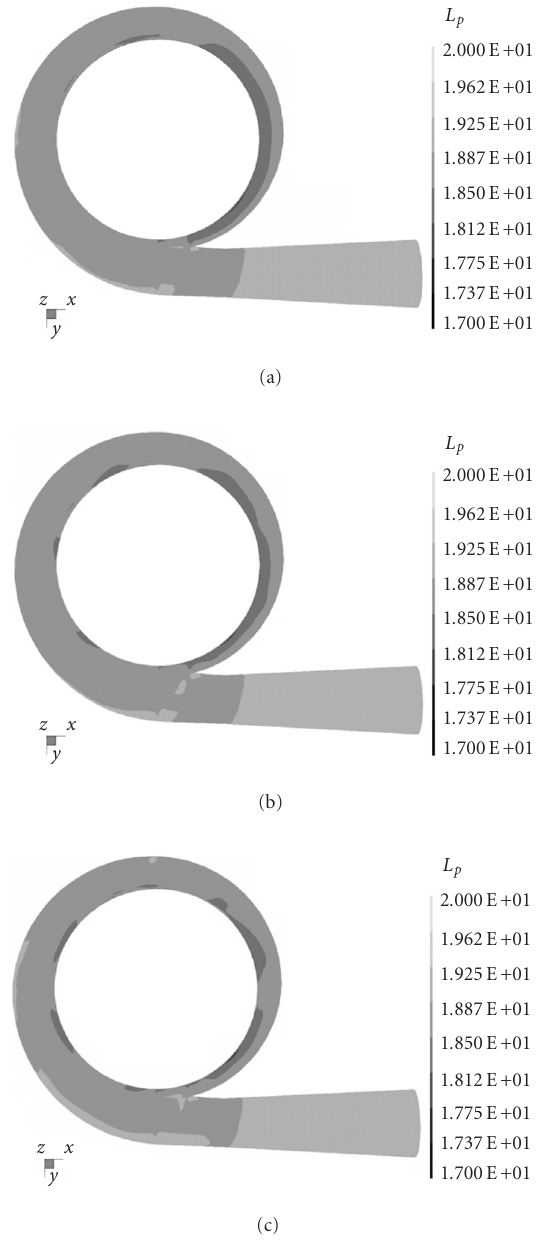
Figure 21: Static pressure on the volute surface for the vaneless case at near-surge conditions: (a) starting position, (b) 1 / 3 revolution, and (c) 2 / 3 revolution.